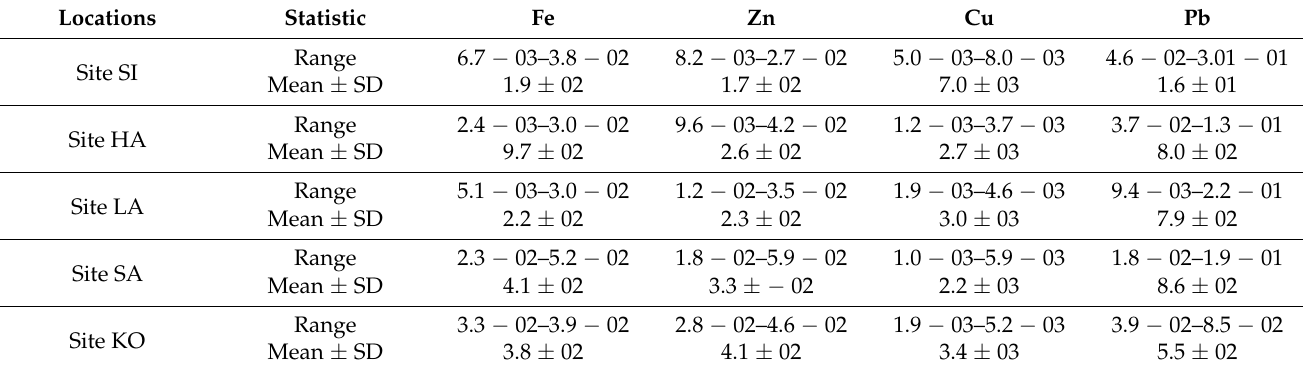
Table 4. HRI for heavy metal via consumption of roof-harvested